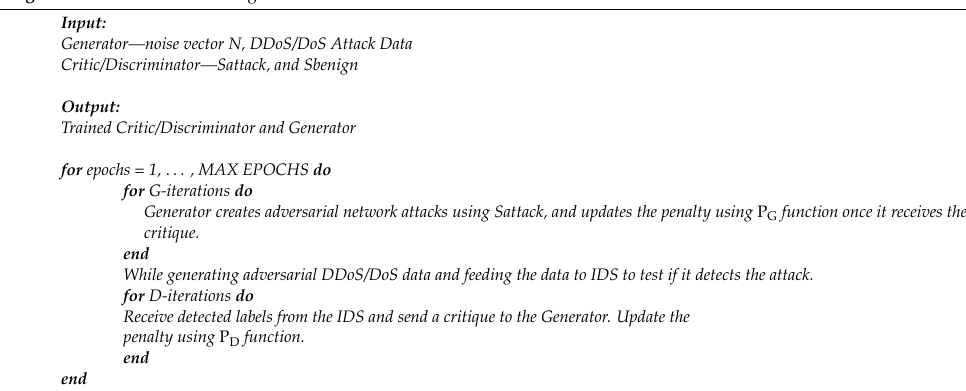
Algorithm 1. Adversarial attack